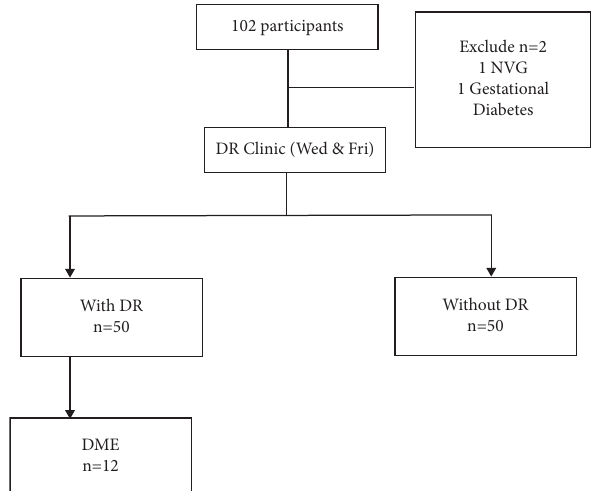
Figure 1: Result fowchart of participants attending the medical and eye clinics. DR: diabetic retinopathy; DME: diabetic macular enema; NVG: neovascular